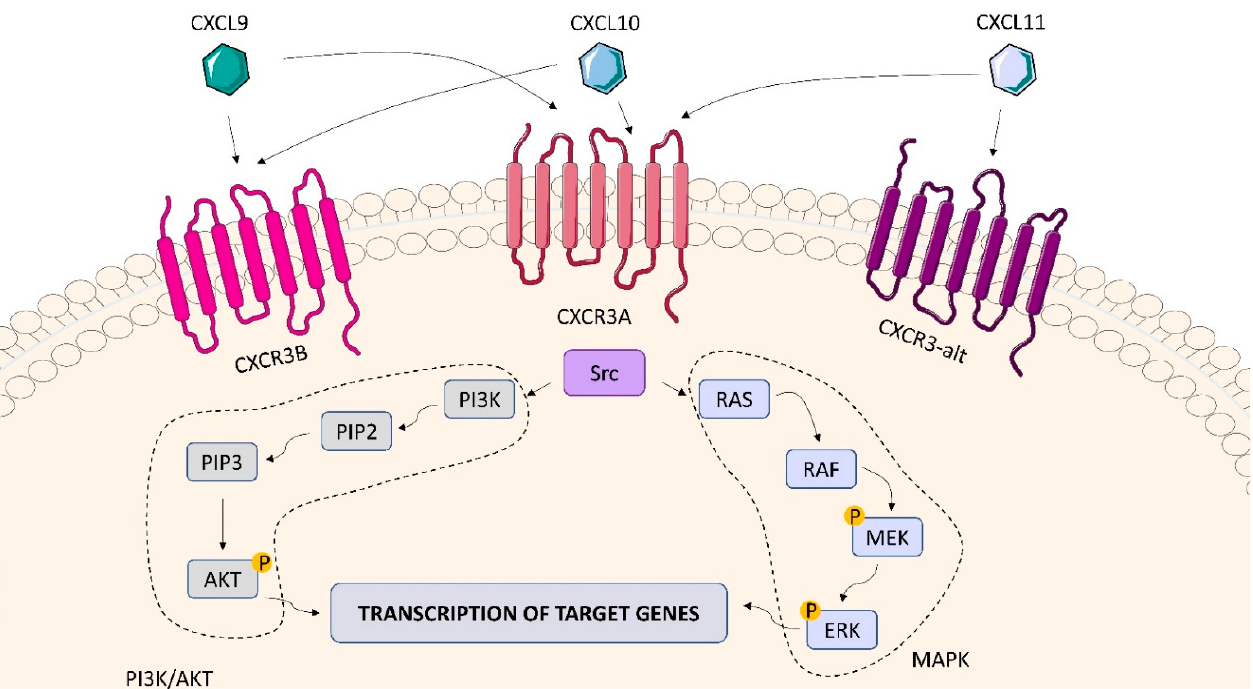
Figure 13. CXCR3 structure and signaling. CXCR3 receptors include CXCRB, CXCXRA, and CXCR- alt. The interaction of chemokines (CXCL9, CXCL10 and CXCL11) with CXCR3 activates the Src, Pi3K and MAPK signaling pathways, which stimulate the transcription of genes in the cell nucleus, leading to the production of cytokines.